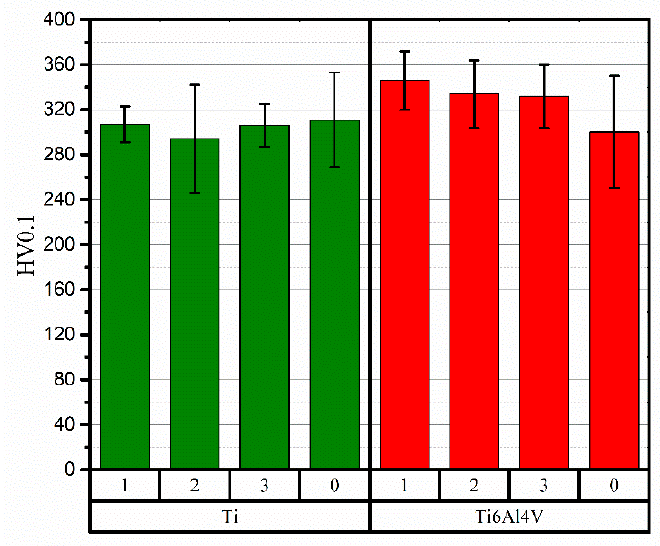
Figure 11. Results of the microhardness measurements.